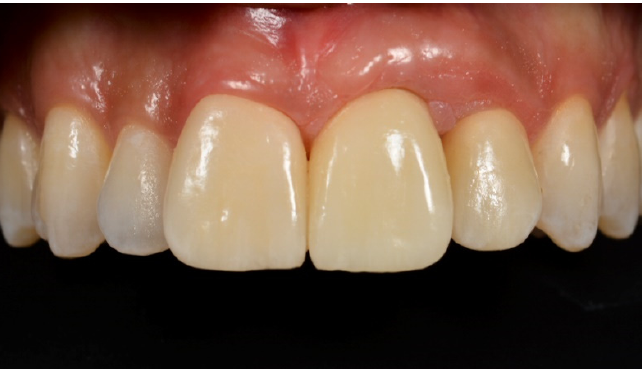
Figure 18. Soft tissue maturation and definitive restorations 1 year after CTG.